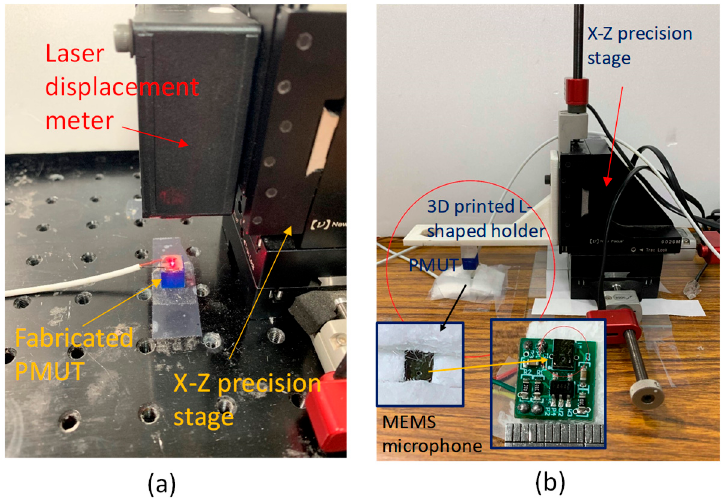
Figure 5. ( a ) Experimental setup for characterizing the PMUT performance. ( b ) Experimental setup for characterizing the PMUT–microphone pair for a range-finding